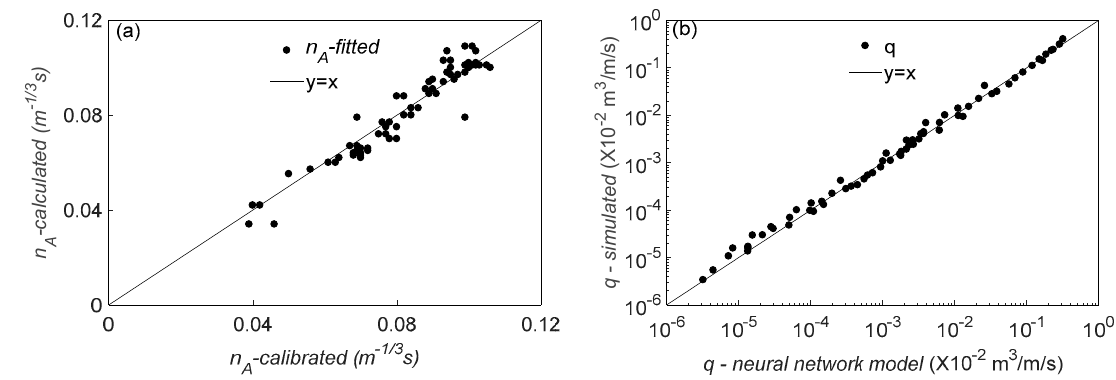
Figure 7. Comparison of the calculated n A and the calibrated n A ( a ) and the predicted q by the neural network and numerically simulated q ( b ) by the SWASH model.